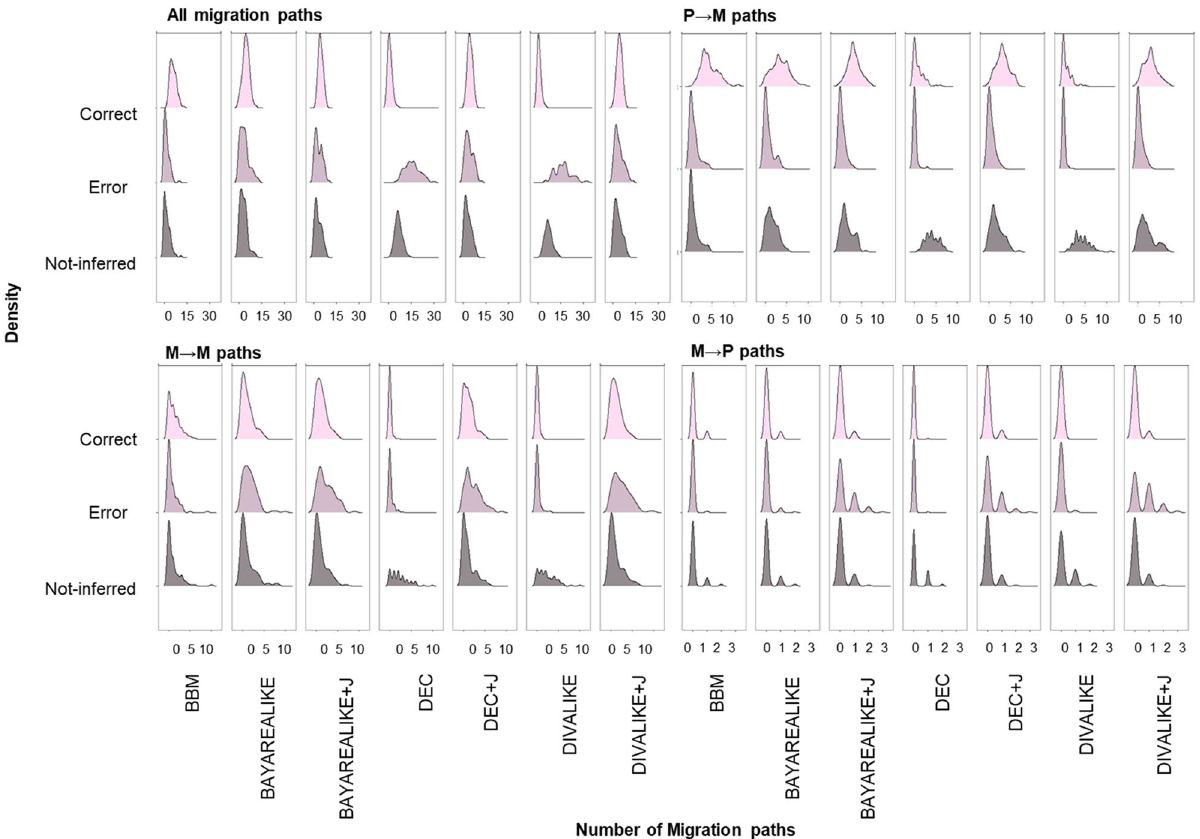
Figure 6. Correct, erroneous, and not-inferred migration paths inferred using seven biogeographic models. Here, we show the results depending on the source-area of the migration: all migration paths, primary to metastasis (P → M), metastasis to metastasis (M → M), and metastasis to primary (M →